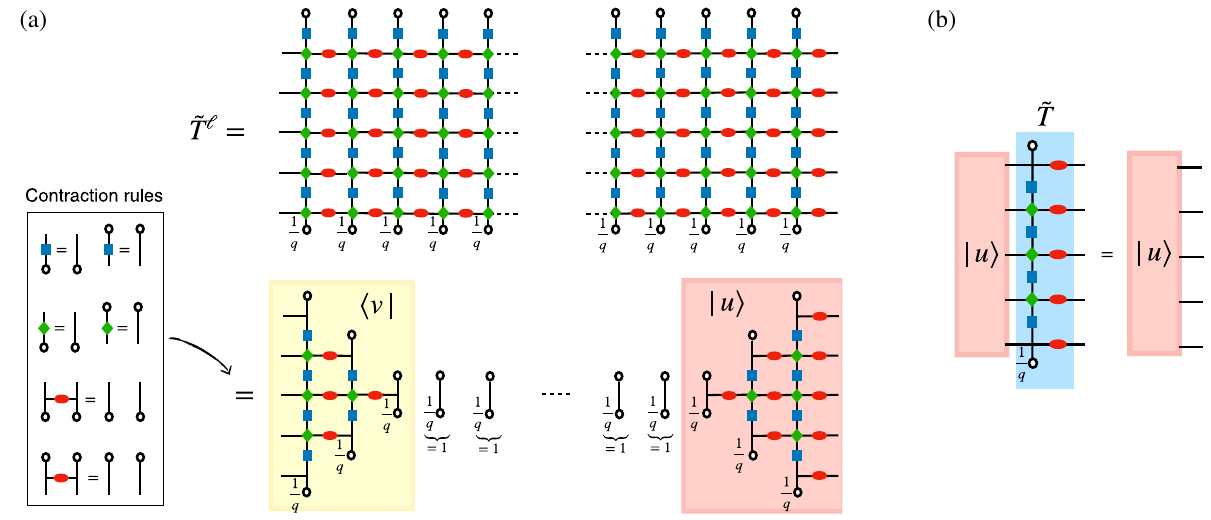
FIG. 3. (a) Illustration of the pseudoprojection property in Eq. (10). The Keldysh path integral can be represented by a folded circuit ˜ T l and hence evaluated sequentially in the space direction, yielding the iteration of the dual transfer matrix (blue shaded tensor) as in Eq. (9) (cf. Fig. 2). Unitarity of time evolution allows the contraction of the network using the rules in the framed box on the left. Performing all possible contractions, one finds that for l > t the input (left) and output (right) legs belong to disconnected networks, bounded by the upper and lower light cones. These two networks define vectors h v j and j u i , respectively. Hence, the result can be interpreted as the decomposition in Eq. (10). (b) Illustration of the eigenvector equation of the dual transfer matrix, which gives the self- consistency equation for the influence matrix of the system (see